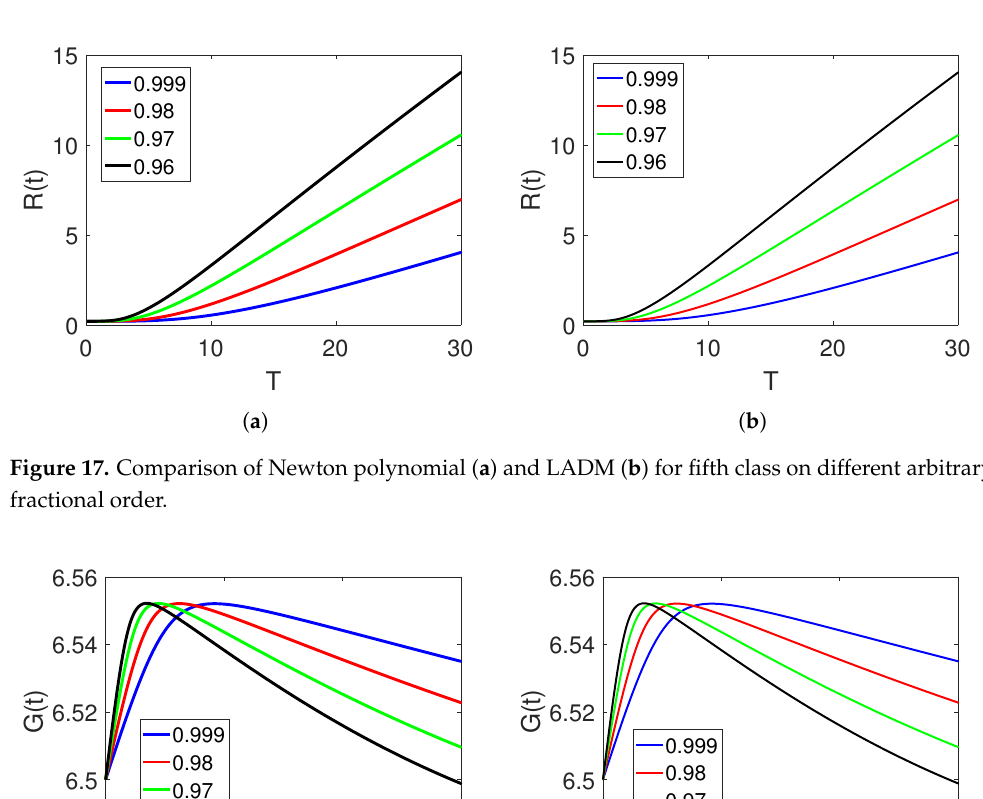
Figure 16. Comparison of Newton polynomial ( a ) and LADM ( b ) for fourth class on different arbitrary fractional order.